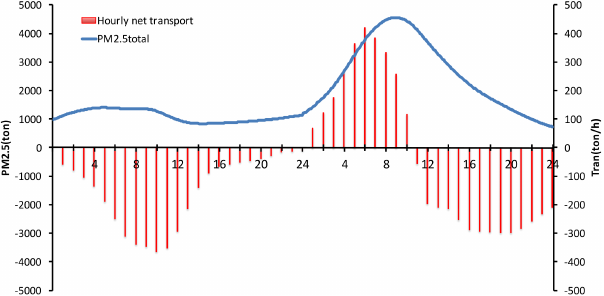
Table 2. Station